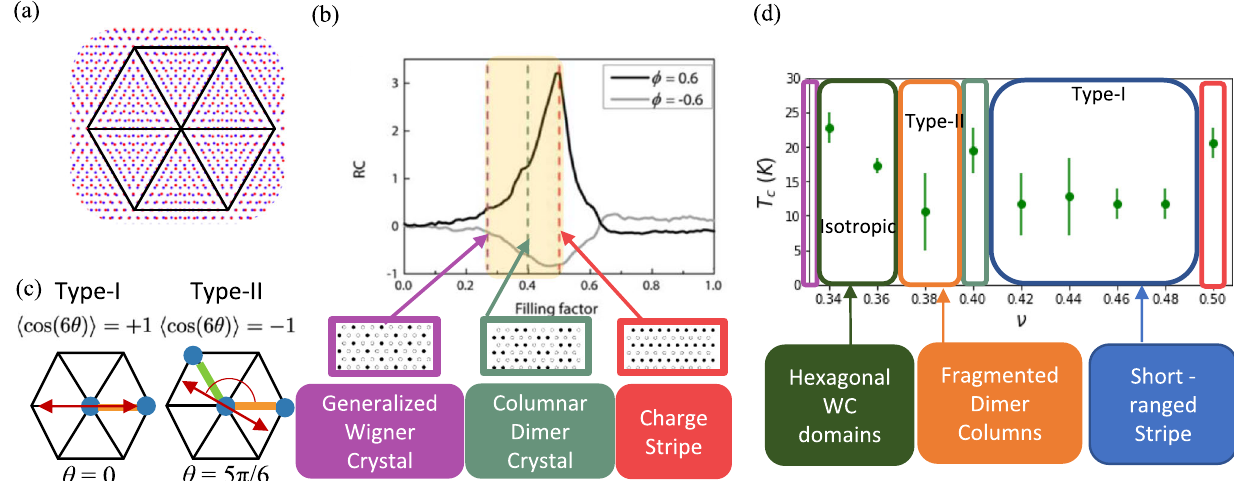
Type-II nematics (right) have a nematic director oriented perpendicular to a single minority bond orientation at θ ∈ { π /6, π /2,5 π /6} and have h cos ð 6 θ Þi = (cid:3) 1. d The critical temperature as a function of Moiré lattice fi lling as determined by Monte Carlo. At 1/3-, 2/5-, and 1/2- fi lling we fi nd the same charge-ordered states as in ( b ). isotropicstatede fi